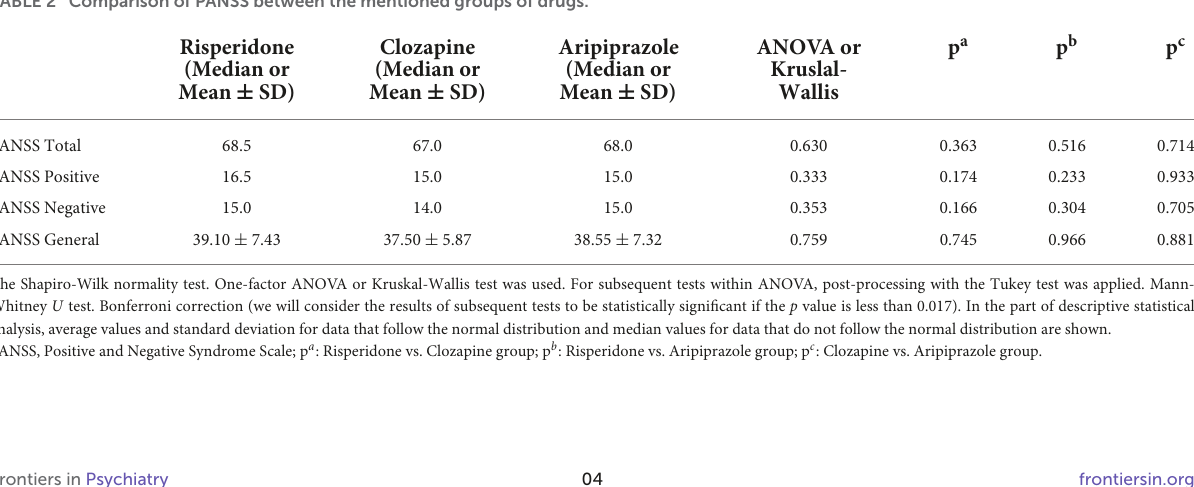
TABLE 2 Comparison of PANSS between the mentioned groups of